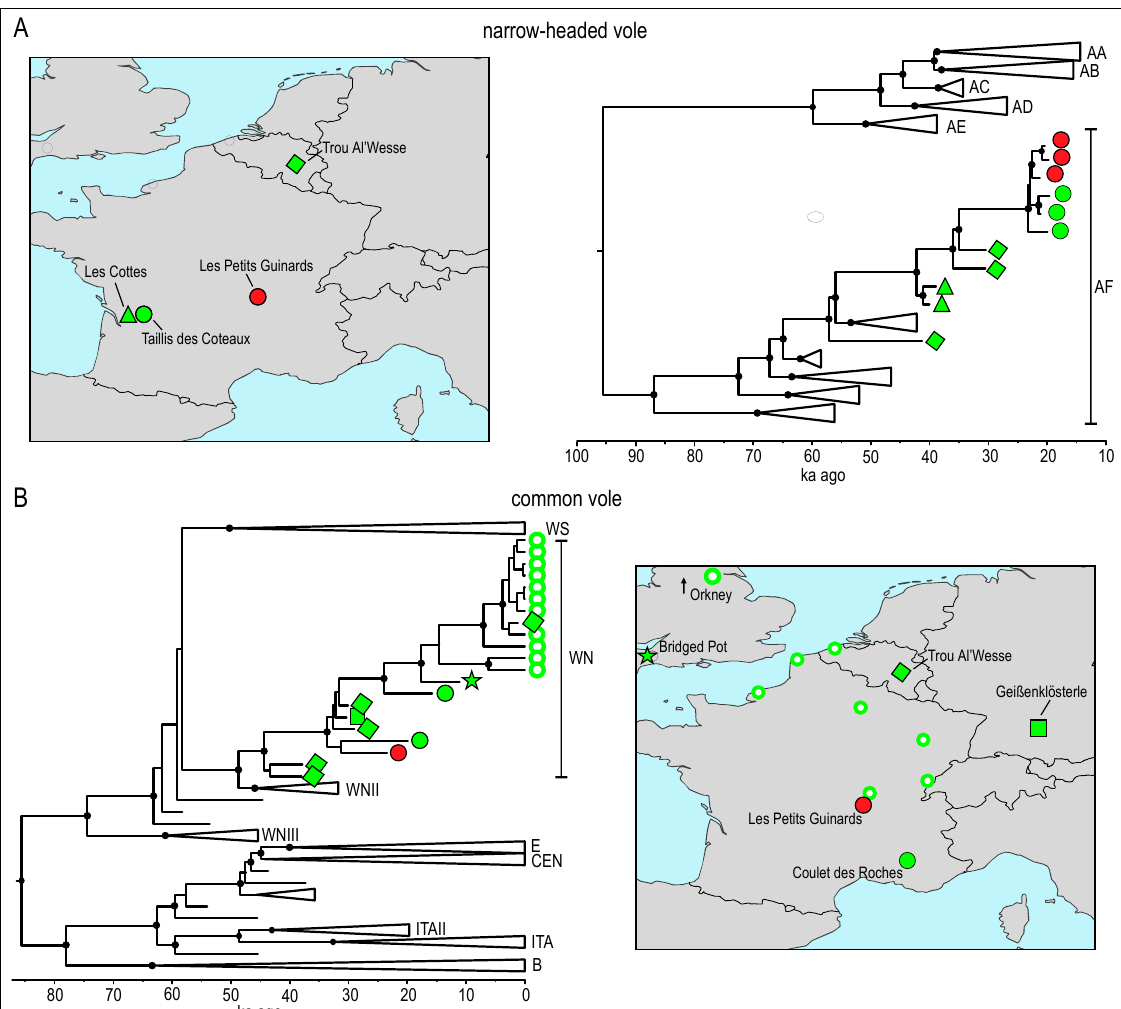
Figure 3. Genetic analyses of Les Petits Guinards specimens. ( A ) The Bayesian phylogeny of European narrow-headed voles ( Stenocranius anglicus ) based on mtDNA genome sequences. The Asiatic lineages ( S. gregalis and S. raddei ) are not shown. ( B ) The Bayesian phylogeny of European common voles ( Microtus arvalis ) based on 4.2 kb fragment of mtDNA. On both panels, the majority of the branches were collapsed and only a fragment containing sequences originating from Les Petits Guinards is presented. Symbols at tips denote localities, as presented on the accompanying maps. The filled symbols represent Late Pleistocene and empty symbols represent modern localities. Black dots indicate nodes with posterior probability above 0.95.